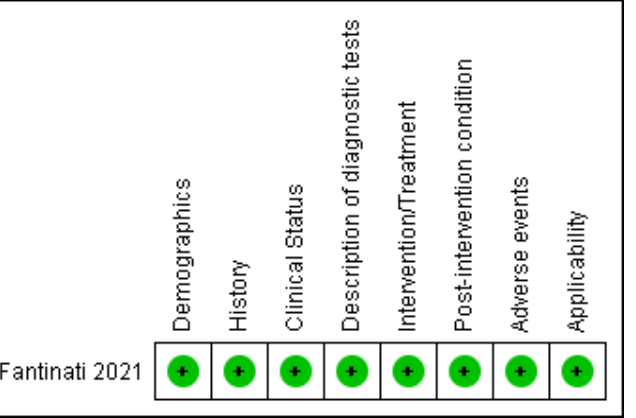
Figure 7. Reporting guidelines summary: review authors’ judgements about reporting on each cri- terion as percentage across all included studies.